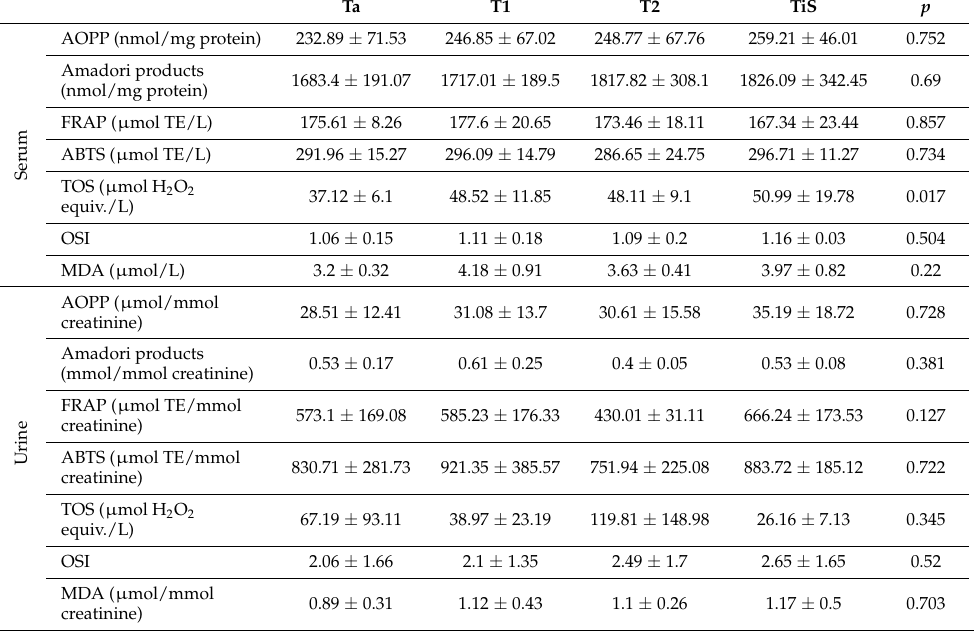
Table 3. Markers of oxidative stress in participants with bladder cancer depending on the TNM classification